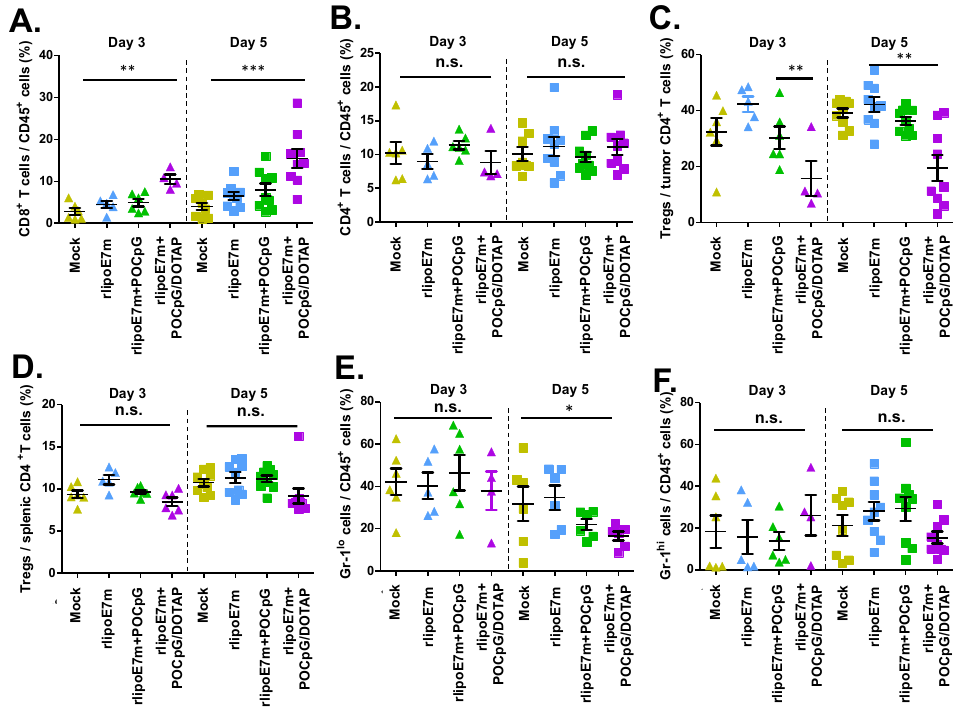
Figure 5. The combination of rlipoE7m plus POCpG/DOTAP could alter tumor-infiltrating immune cells. Mice were inoculated with TC-1 tumor cells and immunized via the tail vein as shown in Figure 4. Tumor-infiltrating cells were collected from tumors 3 and 5 days after the second immunization. The percentage of ( A ) CD8 + cells, ( B ) CD4 + cells, ( C ) Foxp3 + Tregs in CD4 + cells, ( E ) monocytic cells and ( F ) granulocytic cells in CD45 + tumor-infiltrating cells, and ( D ) Foxp3 + Tregs in CD45 + cells in spleens were analyzed by flow cytometry. These data were collected and analyzed from two independent experiments. (* p < 0.05; ** p < 0.01; *** p < 0.001. Each mouse group n = 5 to 9).